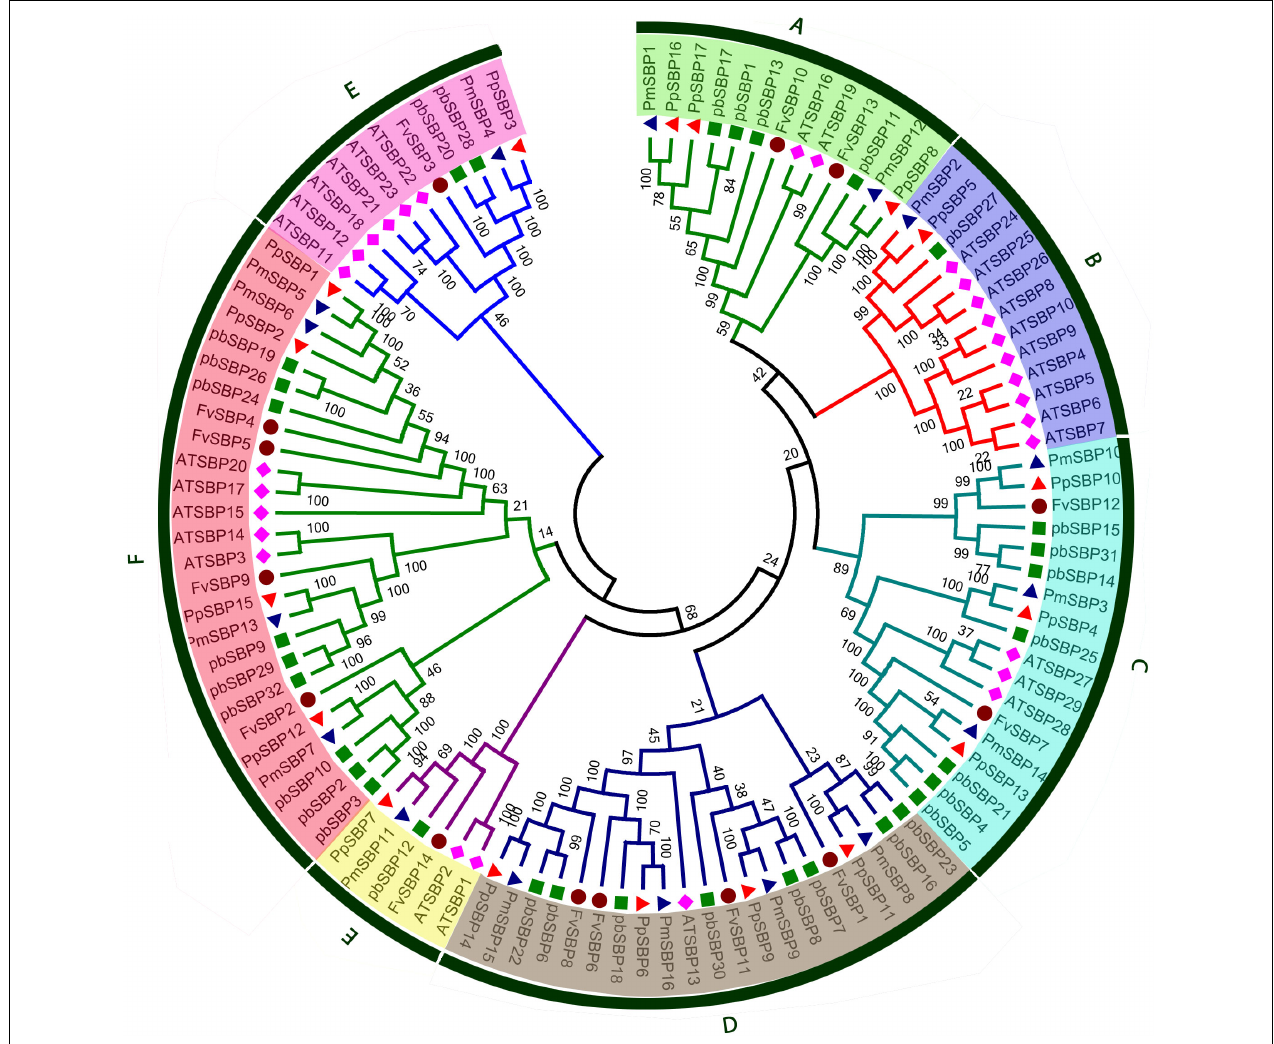
FIGURE 2 | Phylogenetic tree of SBP protein from Strawberry, Pear, Peach, Arabidopsis , and Mei. The tree was generated with MEGA 5 software using the neighbor-joining